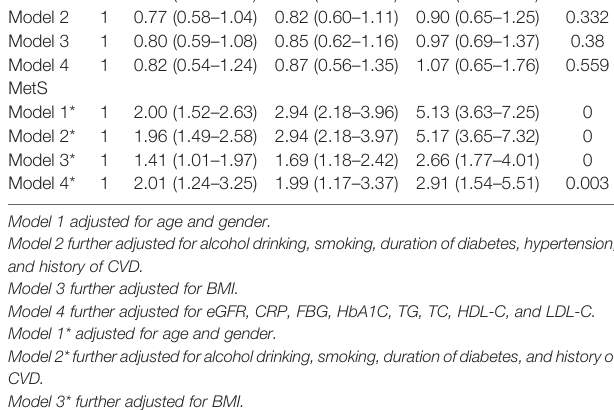
Model2*furtheradjustedforalcoholdrinking,smoking,durationofdiabetes,andhistoryof CVD.